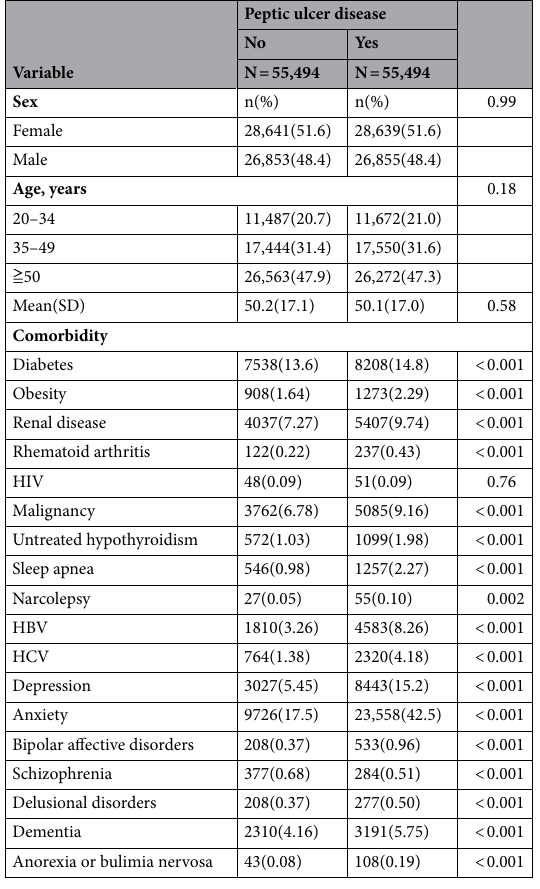
Table 1. Demographic characteristics and comorbidity in patient with and without peptic ulcer disease. Chi- square test; #: Two sample T-test. HIV human Immunodeficiency virus, HBV hepatitis B virus, HCV hepatitis C virus, SD standard